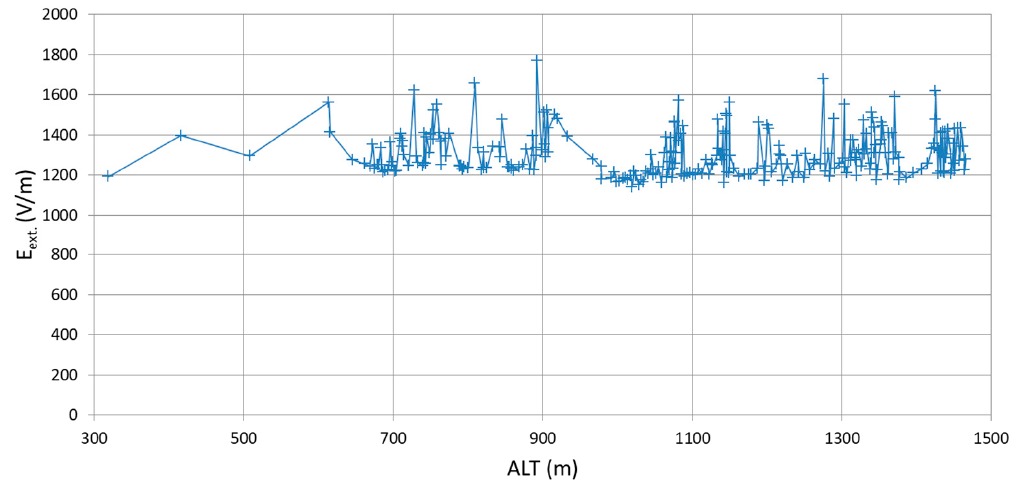
Figure 11. The calculated (by Equation (3)) external electric field strength E ext . for the altitudes between 300 and 1500 m.